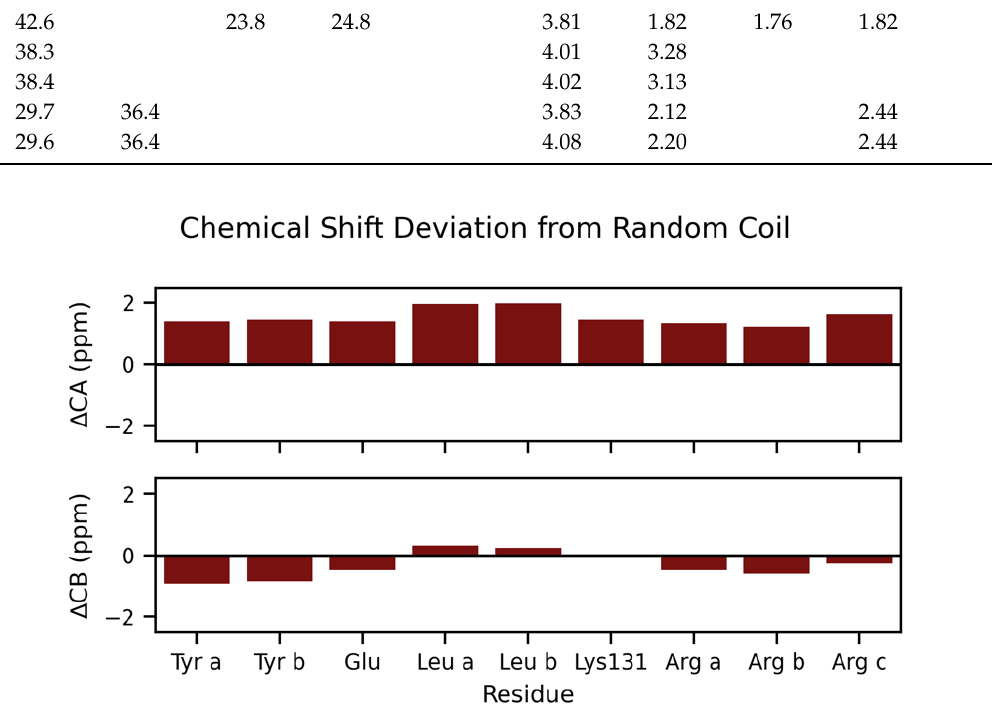
Figure 7. Chemical shift deviations from random coil of residues in the KcsA C-terminus at neutral pH condition KcsA using hCCH-TOCSY data, U- 1 H, 13 C, 15 N-KcsA in proteoliposomes (9:1 DOPE- DOPS) at pH 7.2, 50 mM K + .